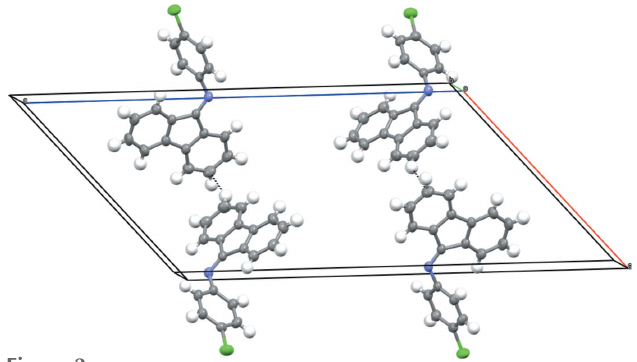
Figure 2 The unit-cell packing in the title compound as viewed along [010]. The C—H (cid:3)(cid:3)(cid:3) (cid:2) contact is shown as a black dashed line.